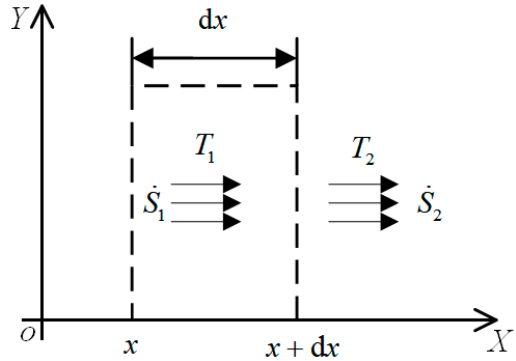
Figure 1. Schematic diagram of entropy conduction.